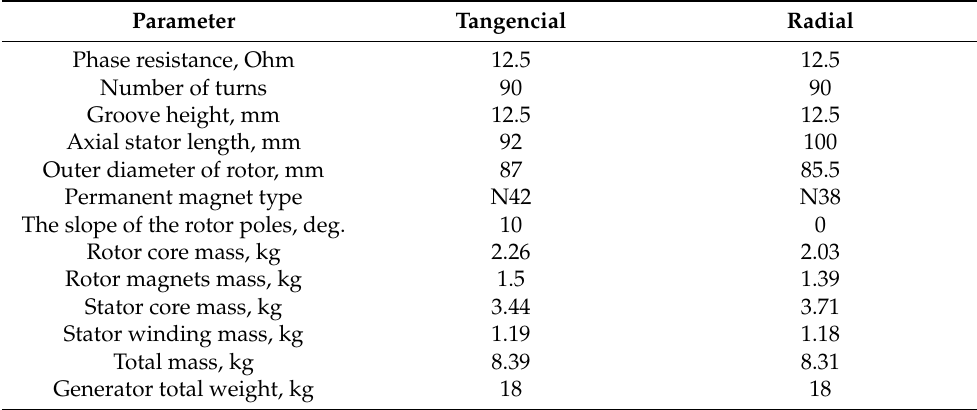
Table 3. Parameters of the computer models used to validate the results of the study.